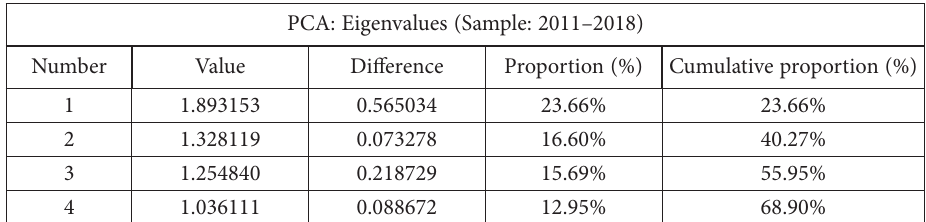
Table 2. Eigenvalues of the principal components (source: authors’ calculation using EViews 9) PCA: Eigenvalues (Sample: